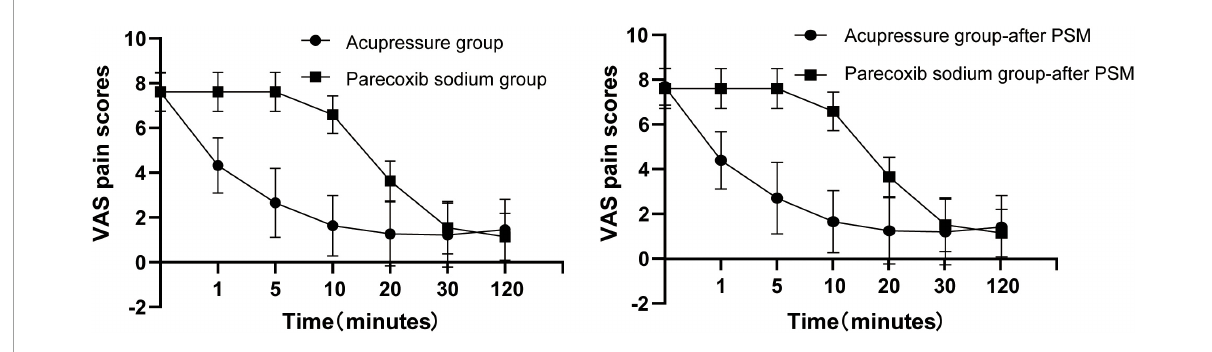
FIGURE3 Visual analog scale (VAS) decrease between the acupressure group and parecoxib sodium group before and after propensity score matching